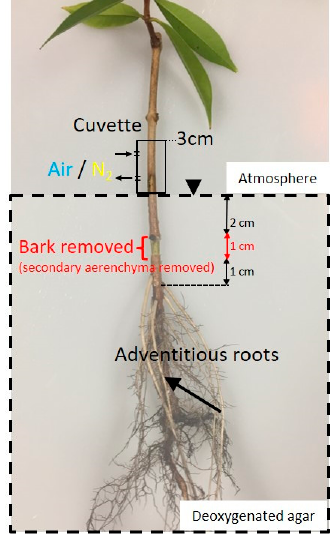
Figure 4. The effect of removal of secondary aerenchyma developed in the stem on the oxygen partial pressure (pO 2 ) in the adventitious roots of Syzygium kunstleri . A 1 cm long section of bark (secondary aerenchyma) was removed from the stem, located 2 cm below the water surface. Air or N 2 was injected at the 0–3 cm portion of stem above the water level through the cuvette(arrows). Arrow: measurement point; arrowhead: water level.